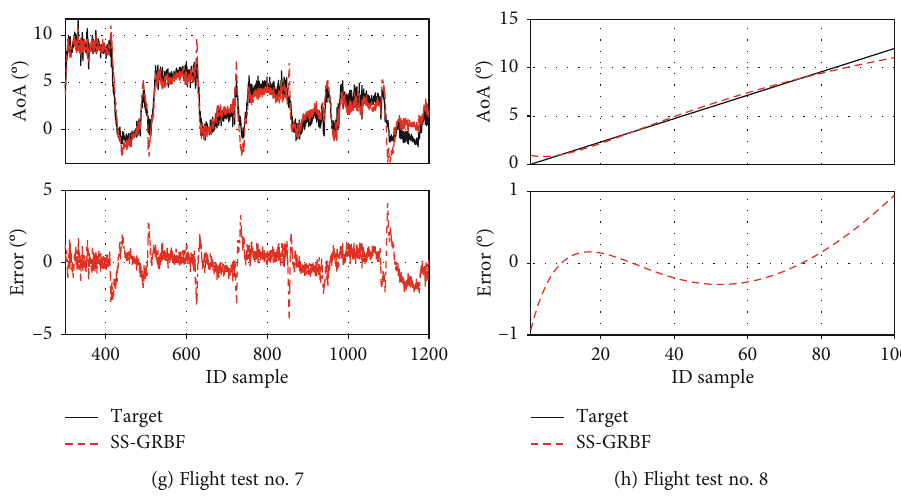
Figure 6: True AoA, estimated AoA, and estimation errors for training and validation manoeuvres.